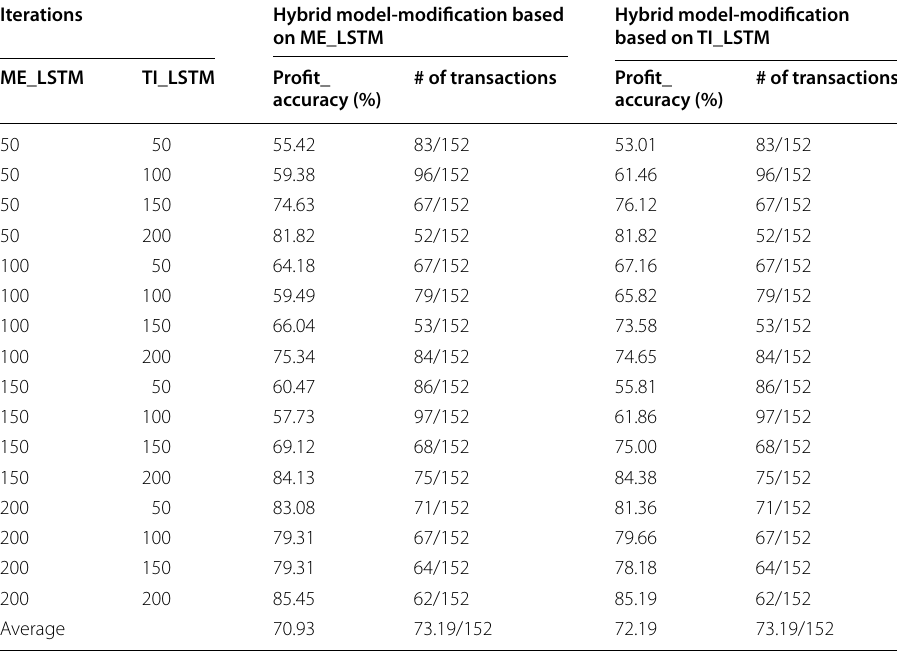
Table 17 Hybrid model (on extended dataset): one‑day‑ahead predictions Iterations Hybrid model‑modification based Hybrid model‑modification on ME_LSTM based on